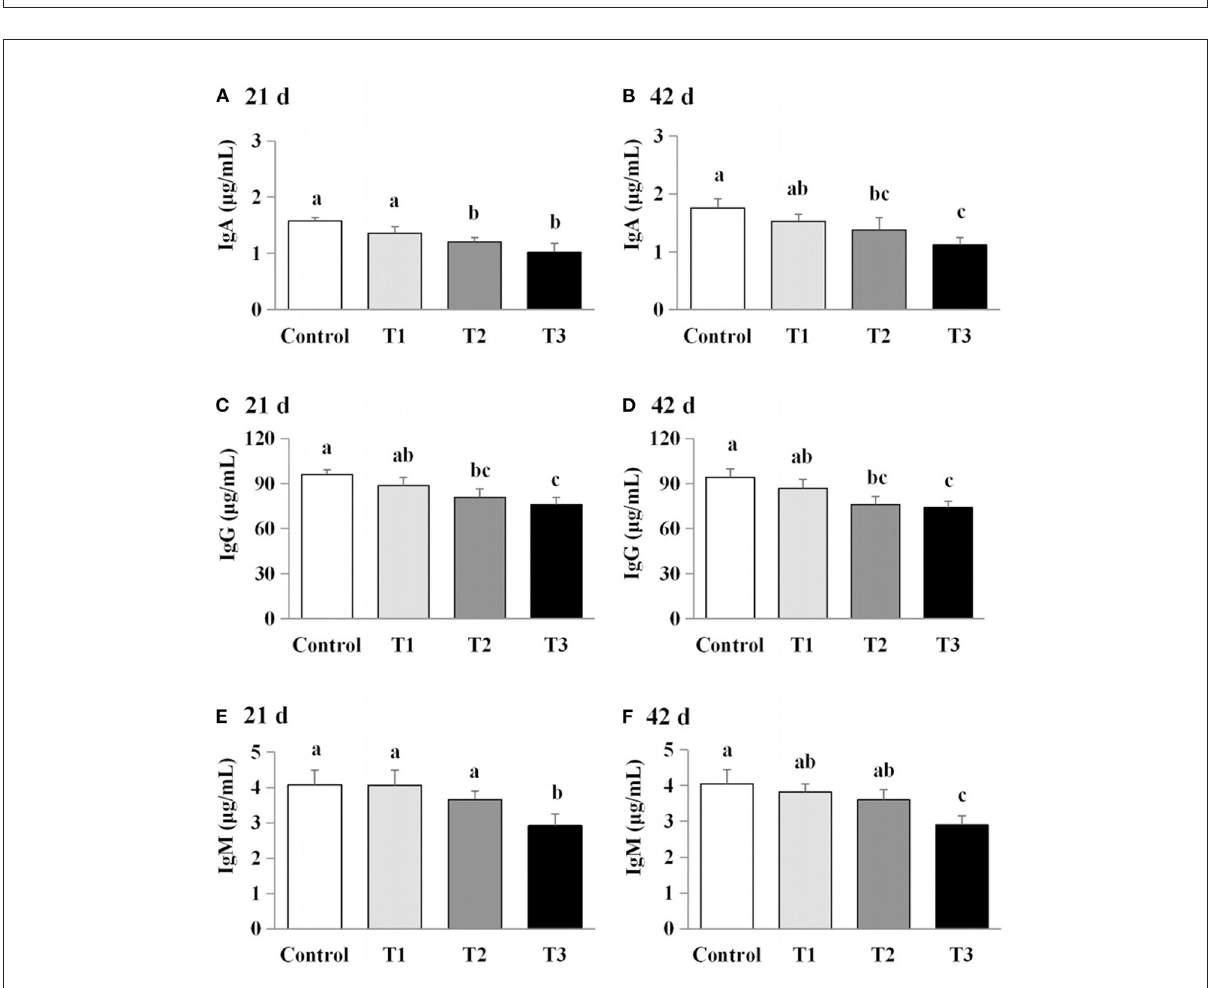
FIGURE3 Effects of AFB 1 on the immunoglobulin content in serum of chicks on day 21 and day 42 (A) IgA content on day 21. (B) IgA content on day 42. (C) IgG content on day 21. (D) IgG content on day 42. (E) IgM content on day 21. (F) IgM content on day 42. Control: control group. T1: low doses of AFB 1 group. T2: medium doses of AFB 1 group. T3: high doses of AFB 1 group. Data represent the means ± SD values of six replicate cages and were compared using one-way analysis of variance (ANOVA) followed by Duncan’s multiple comparison tests. Different letters on the same row indicate significant differences ( P <